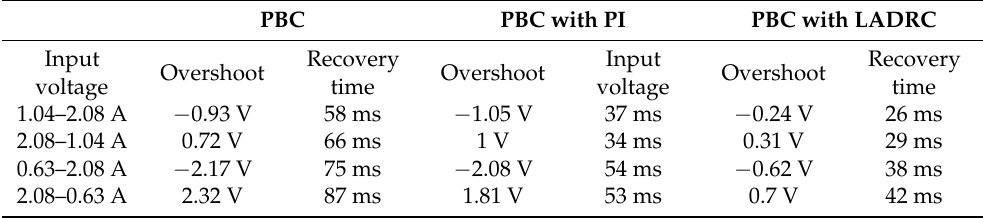
Table 6. The dynamic performance comparison during i 2 step in step-down mode. PBC PBC with PI PBC with